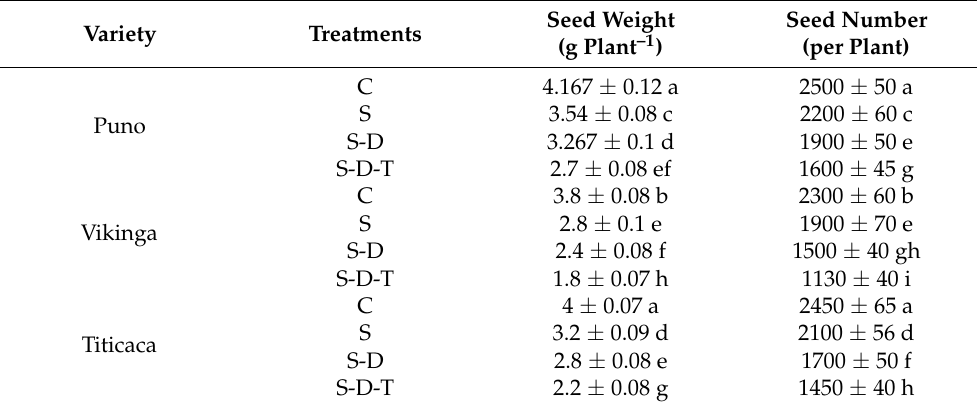
Table 2. Effect of salinity (S), drought (D), and temperature stress (T) on grain yield attributes of quinoa